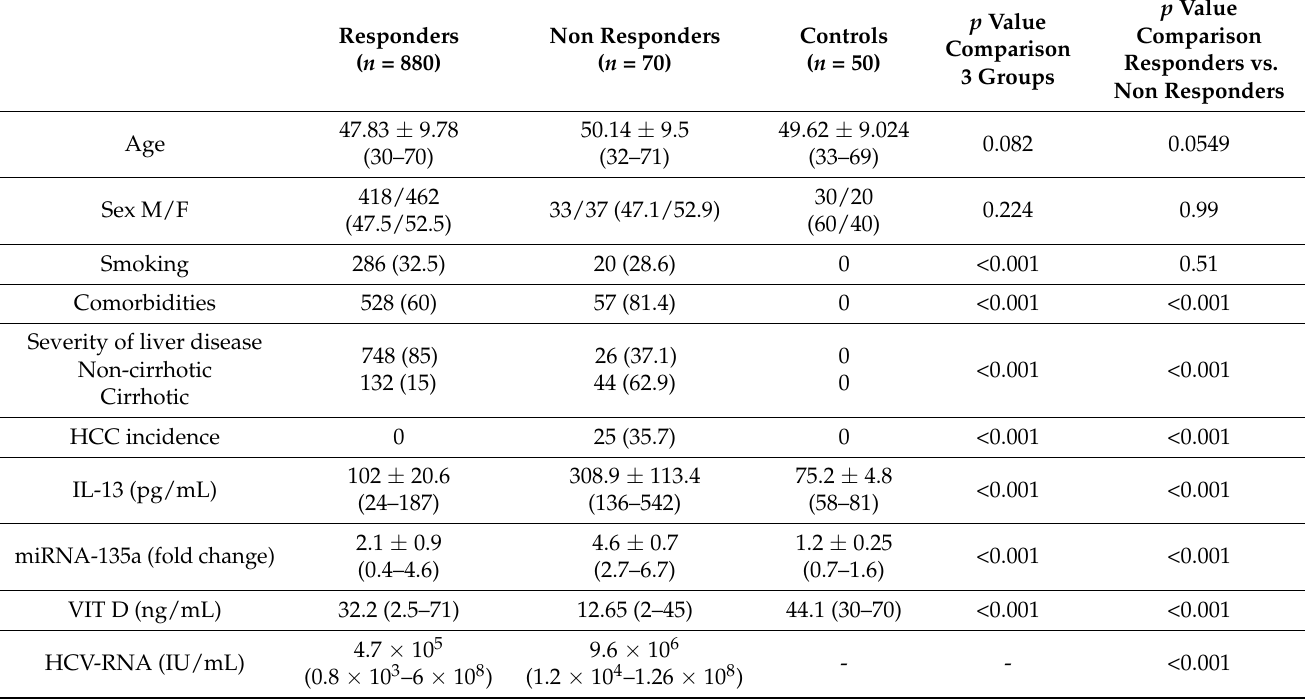
Table 1. Sociodemographic and clinical characteristics of the study